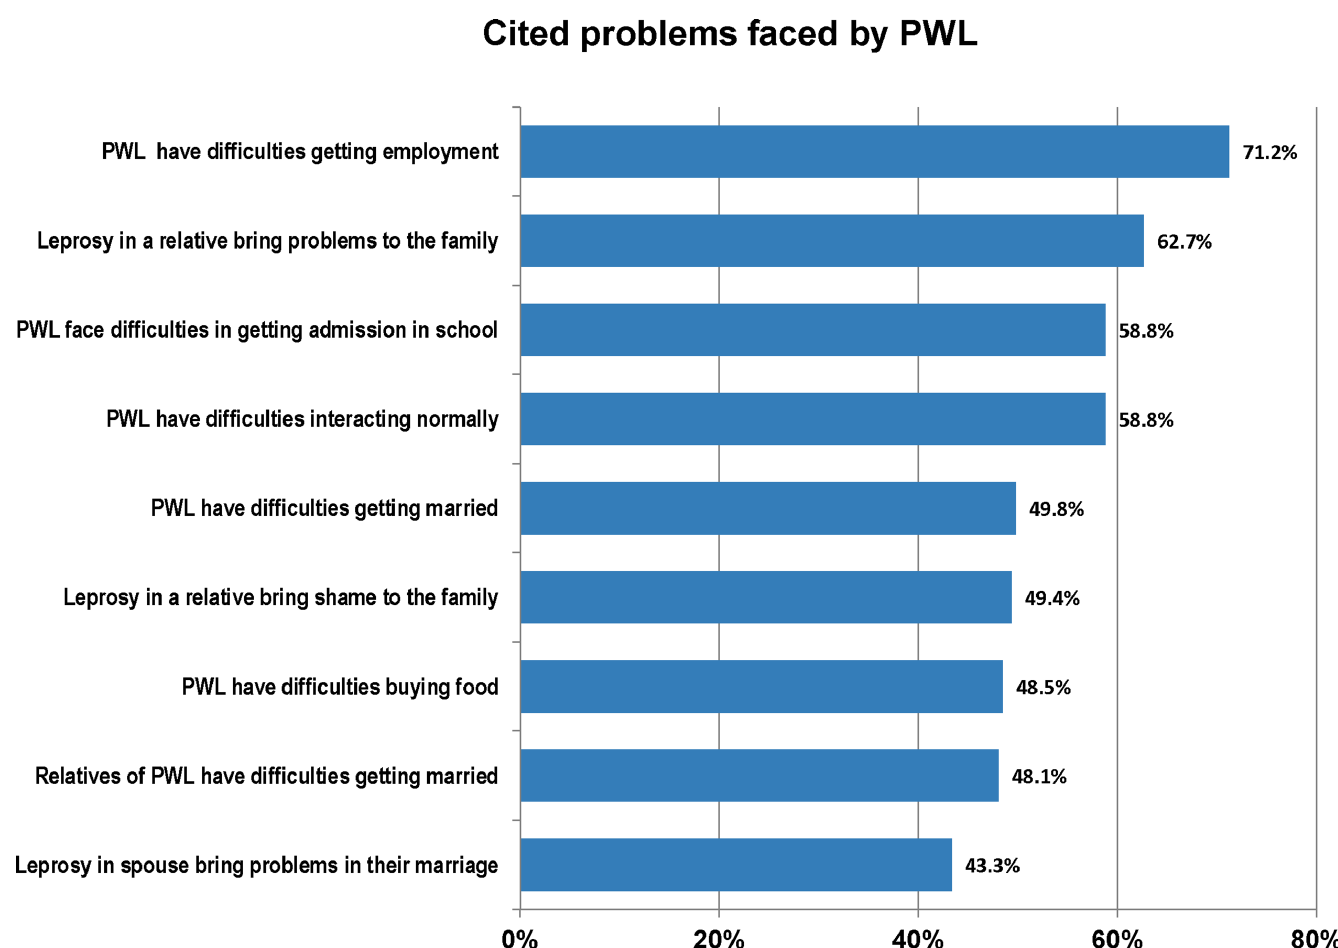
Fig 4. Cited problems faced by people with leprosy. The participants of our study admitted that PWL face a variety of problems in the society, ranging from difficulties getting employment, admission in school, or getting married themselves; to bringing shame in the family and causing other problems to family members.